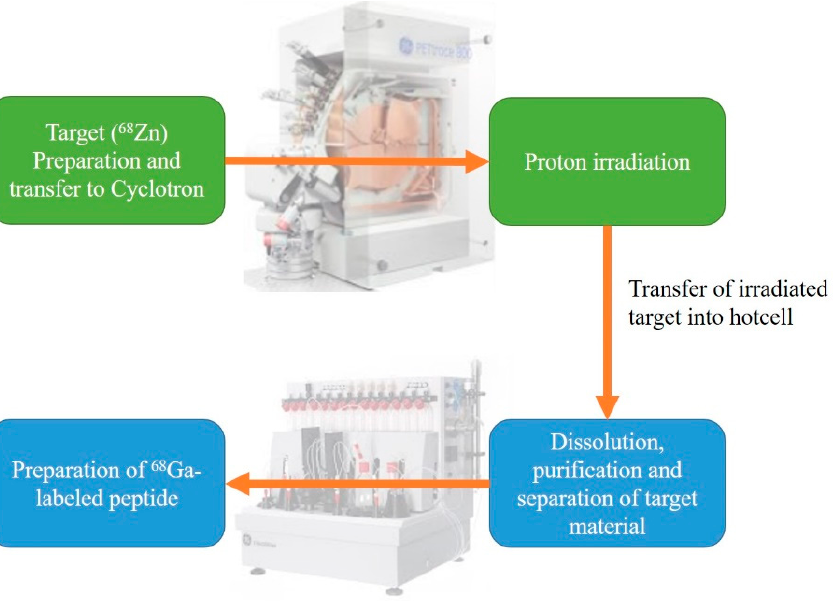
Figure 2. Steps in the production of the 68 Ga-labeled peptide from a medical cyclotron.